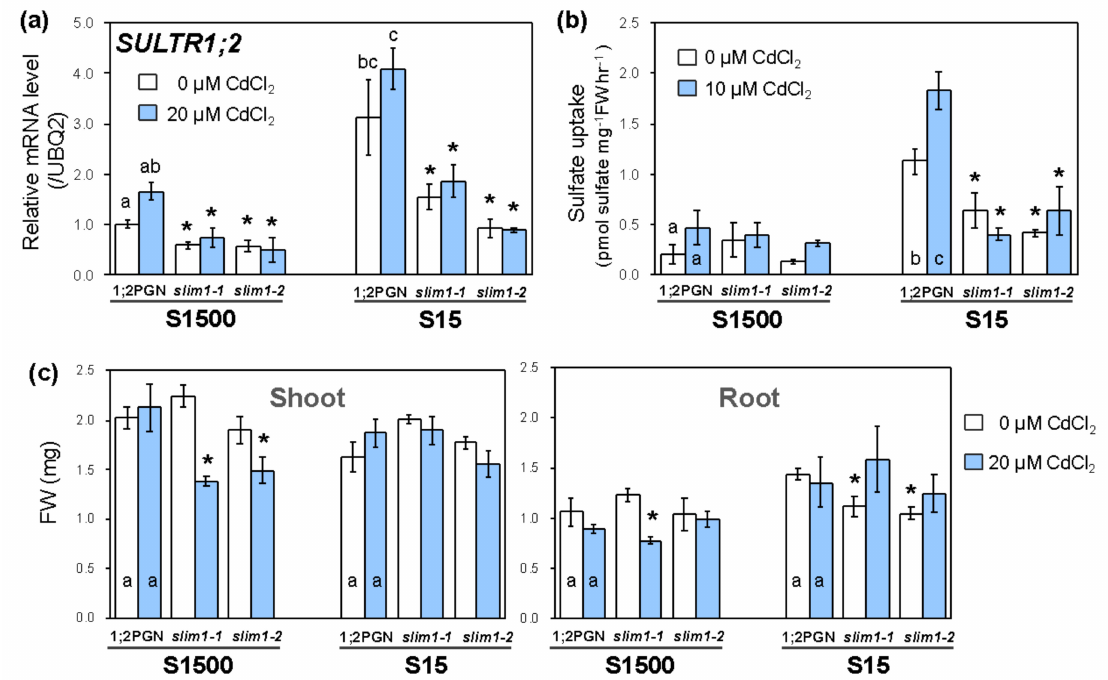
Figure 6. E ff ects of Cd treatment and − S on SULTR1;2 levels, sulfate uptake activity, and plant growth in 1;2PGN and slim1 plants. 1;2PGN and slim1 seedlings were grown for 10 days on MGRL agar medium supplemented with 1500 or 15 µ M sulfate (S1500 or S15, respectively), which contained 0 (white bars) or 10 / 20 (light blue bars) µ M CdCl 2 . ( a ) Transcript levels of SULTR1;2 in roots were determined by qRT-PCR. The average values are indicated with error bars denoting SEM ( n = 2–4). Di ff erent letters indicate significant di ff erences between treatments in 1;2PGN (Tukey–Kramer test; p < 0.05). ( b ) The absolute values of [ 35 S] sulfate uptake rates are presented as averages with error bars denoting SEM ( n = 5–6). Di ff erent letters indicate significant di ff erences between treatments in 1;2PGN (Tukey–Kramer test; p < 0.05). Asterisks indicate significant di ff erences between 1;2PGN and slim1 mutants (Student’s t -test; * p < 0.05). ( c ) Fresh weight of shoots (left graph) and roots (right graph) per plant are presented as averages with error bars denoting SEM ( n = 3–4). Di ff erent letters indicate significant di ff erences between treatments in 1;2PGN (Tukey–Kramer test; p < 0.05). Asterisks indicate significant di ff erences among 1;2PGN and slim1 mutants in the same treatment (Student’s t -test; * p <